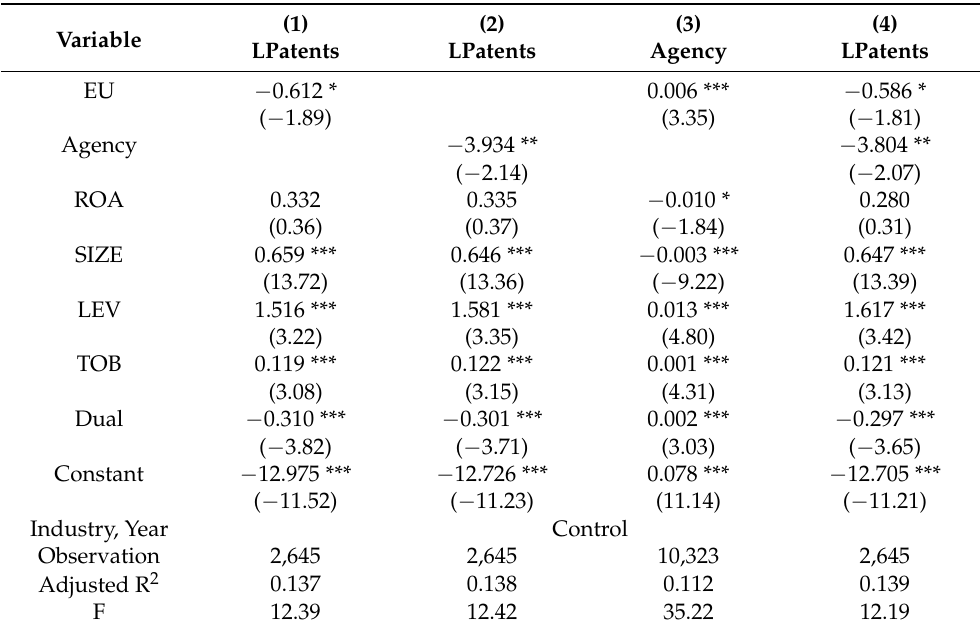
Table 5. Regression analysis of environmental uncertainty, the second type of agency problem and innovation output